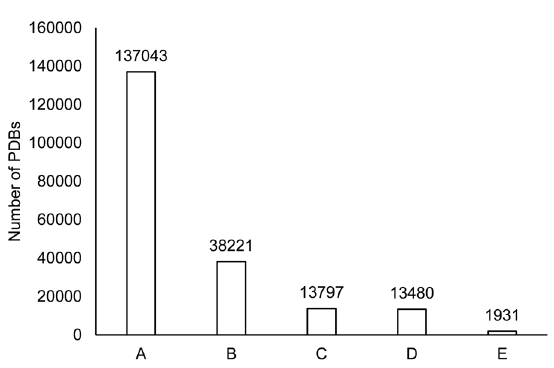
Figure 3. PDBs covered in the creation of NRDB. A: Total protein complexes in PDB, B: PDBs reported in SCOP 1.75, C: PDBs selected for PPII generation, D: PDBs for which PPIIs were generated, E: PDBs covered in